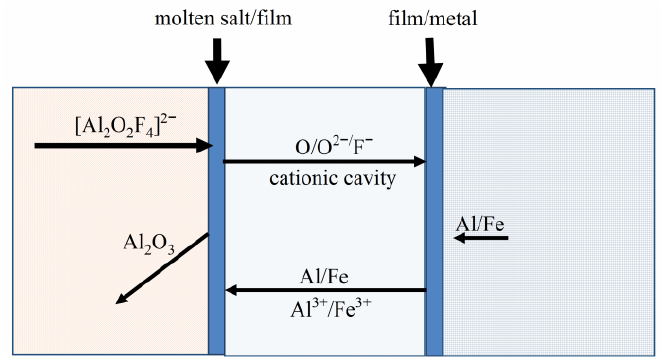
Figure 6. The SEM micrograph ( a ) and EDS mapping with respect to F ( b ), Ni ( c ), Fe ( d ), Al ( e ), and O ( f ) of inner corrosion layer in Figure 3a at higher magnification of 57.9Fe-38.2Ni-3.9Al alloy after electrolytic corrosion in 39.3NaF-43.7AlF 3 -8NaCl-5CaF 2 -4Al 2 O 3 at 850 °C for 5 h. Table 2. Elements compositions of the cross-section of 57.9Fe-38.2Ni-3.9Al alloy analyzed by EDS.